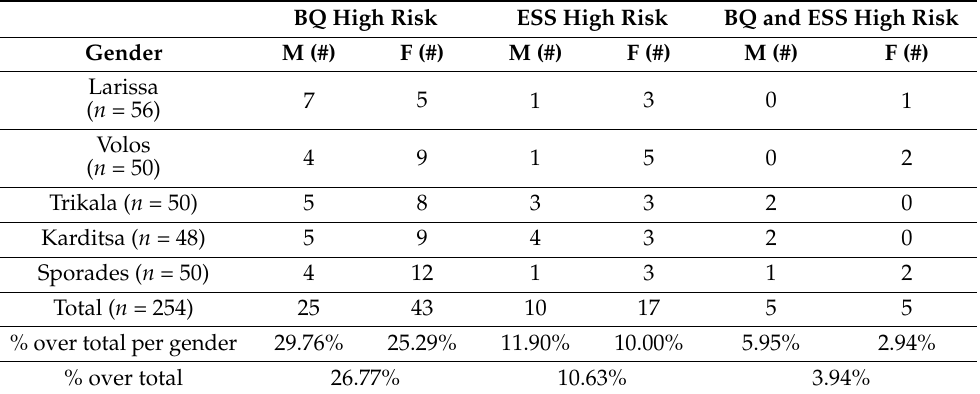
Table 2. High-Risk Prevalence of participants for OSA, EDS and OSAS.